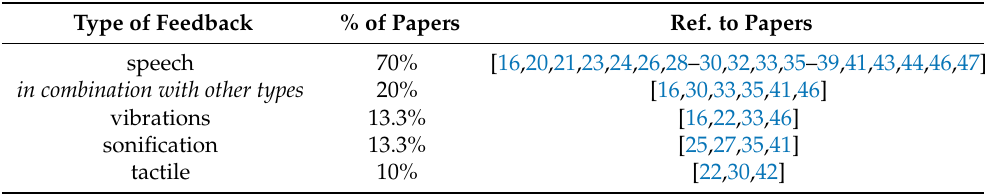
Table 5. General methods and techniques for providing feedback to users. Some tools have only been tested online, and their types of feedback remain theoretical.